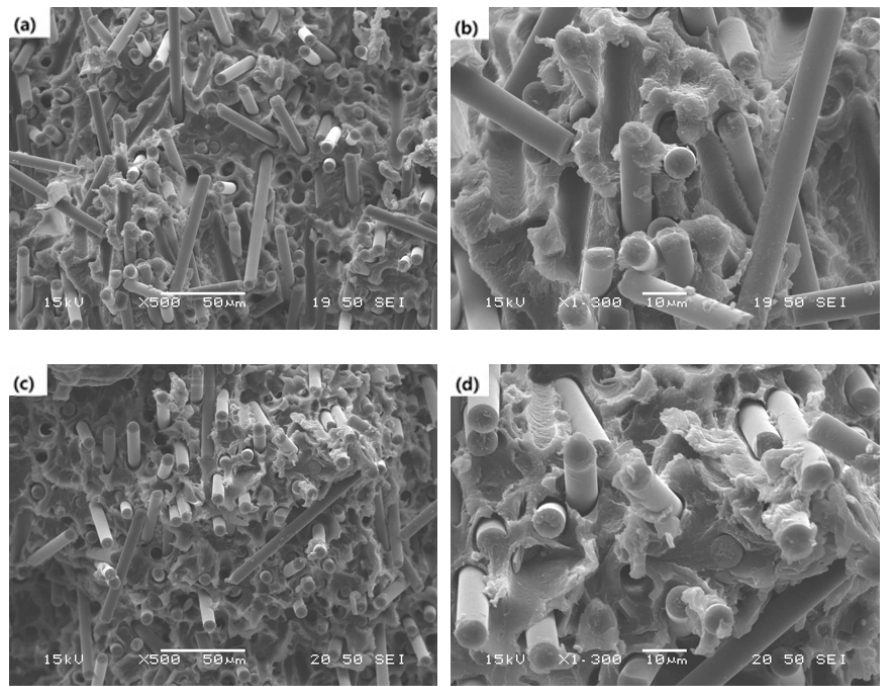
Figure 12. SEM micrographs ( a , c : × 500, b , d : × 1300) showing the fracture surfaces of carbon fiber/ABS composites with ( a , b ) (epoxy + epoxy) dual-sized carbon fiber and ( c , d ) (epoxy + PU) dual-sized carbon fiber.